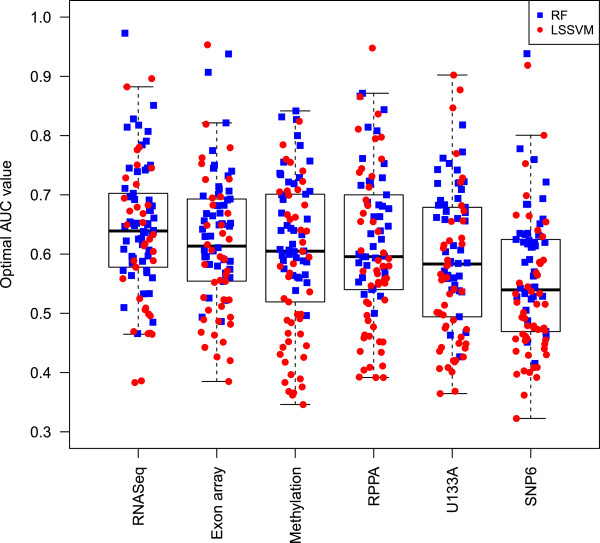
Boxplot of best AUC values for all 90 compounds across 6 data types. For all data types, the highest AUC obtained with either approach (LS-SVM in red circles, or random forest in blue squares) is displayed. For RNAseq and exon array, the highest AUC is shown among models built on gene-level data only versus all features (exons, junctions, and so on). The one-way repeated measures ANOVA test revealed a significant difference in performance among any of the data types (P-value 2.6e-5). Post hoc pairwise comparisons with multiple testing correction revealed a significant outperformance of RNAseq with respect to all other data types. SNP6 copy number performed significantly worse compared to all other data types, and exon array additionally significantly outperformed U133A.